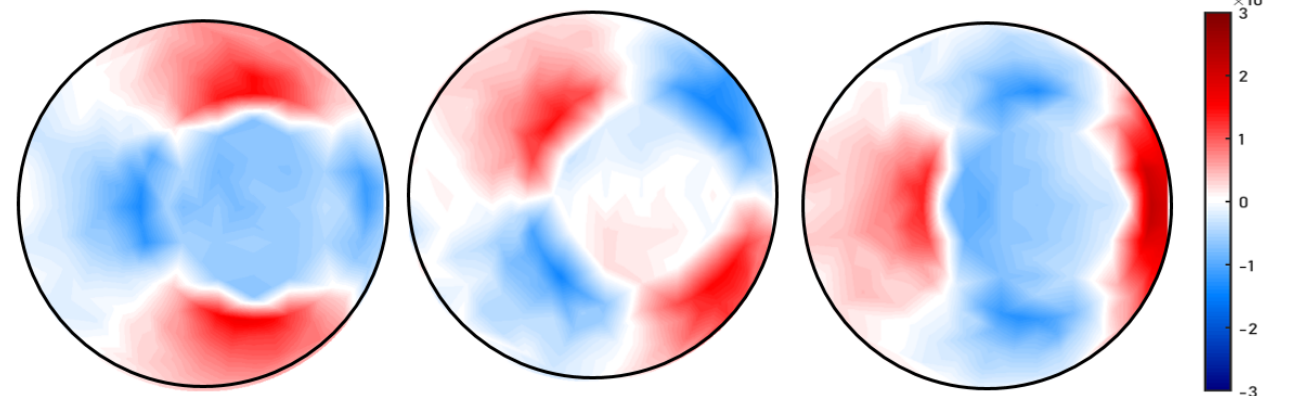
Figure 16. Two-dimensional strain components ε xx , ε xy , ε yy respectively with KOWARI Data.